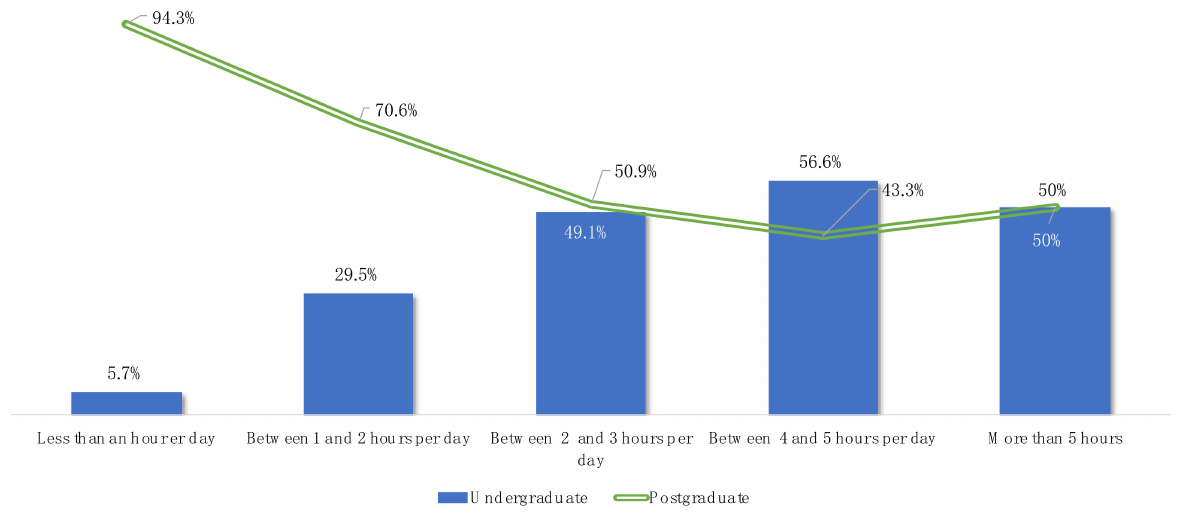
Figure 1. Results for differences in time spent consuming social